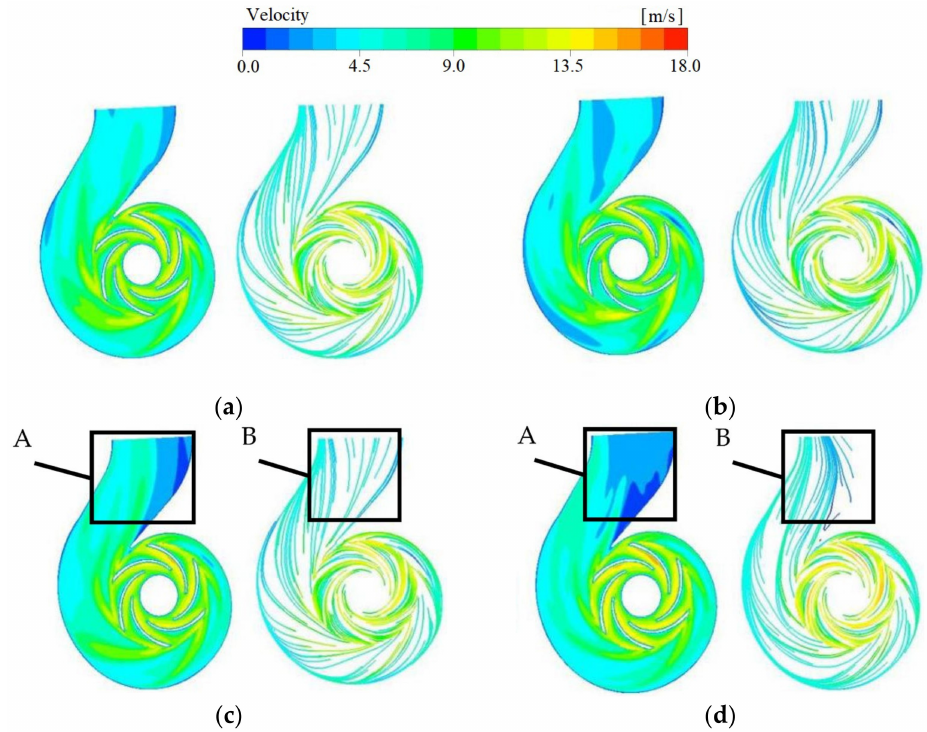
Figure 8. Velocity and streamline distribution of the volute at different flow rates: ( a ) 800 m 3 /h;